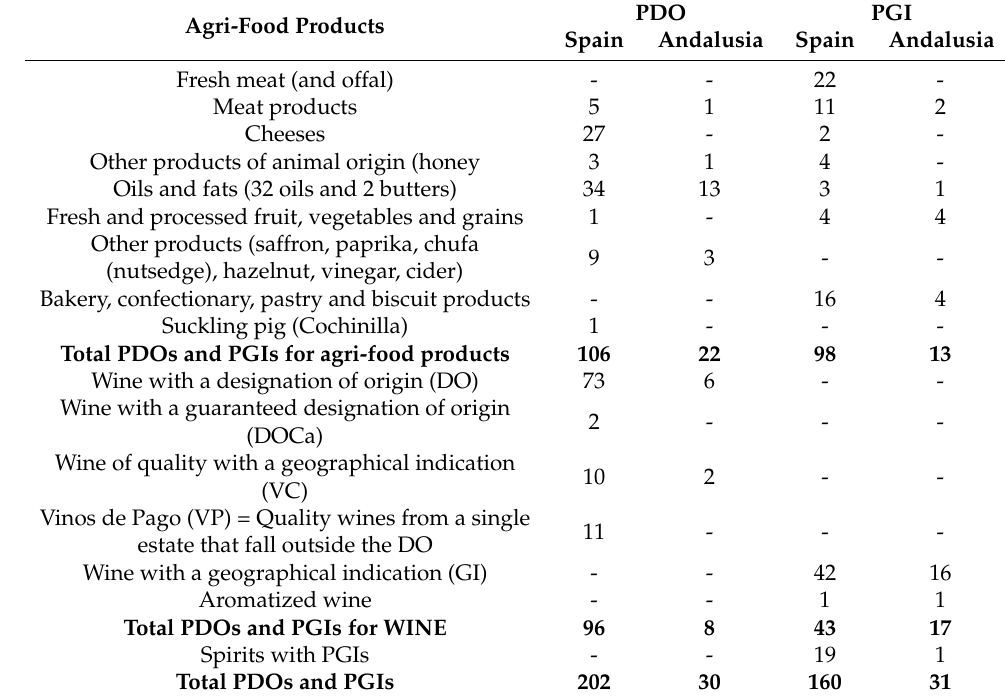
Table 1. Protected designations of origin and protected geographical indications of Spain (year